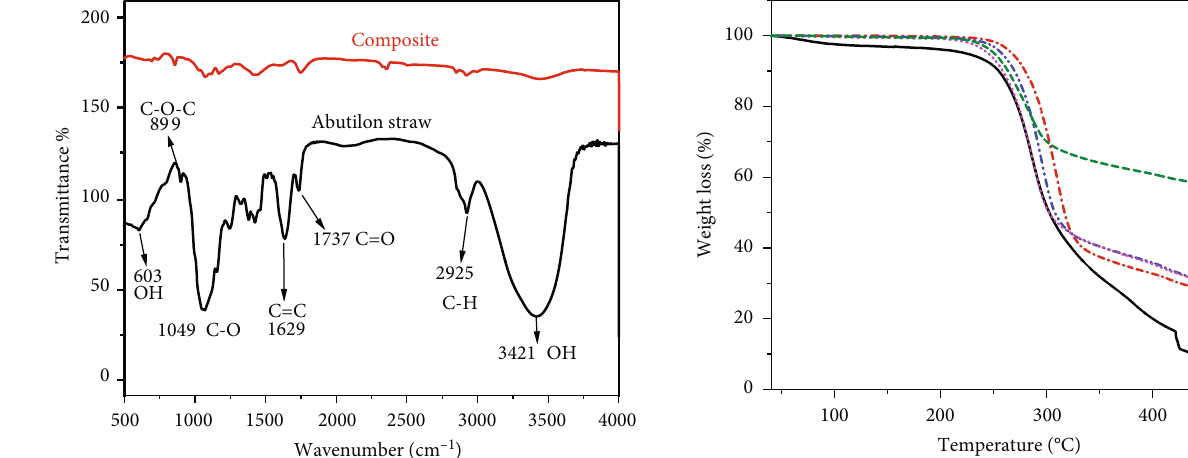
Figure 1: FTIR spectra of abutilon straw and PLA/abutilon straw biocomposites.